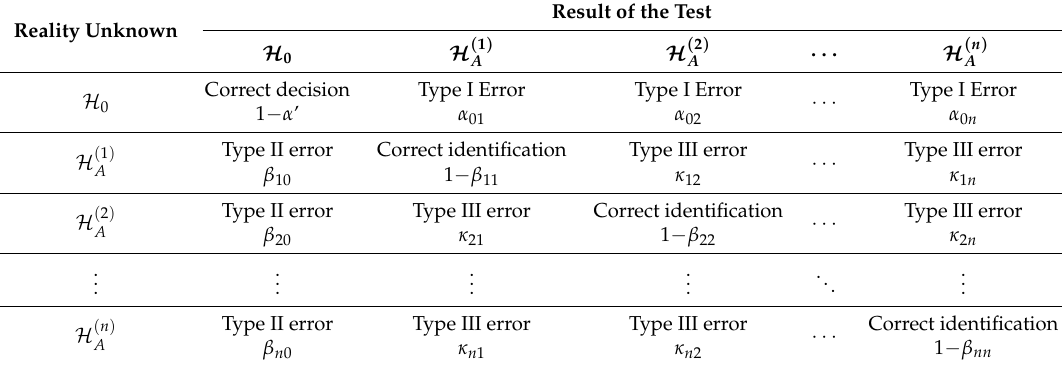
Table 1. Probability levels associated with data snooping under multiple alternative